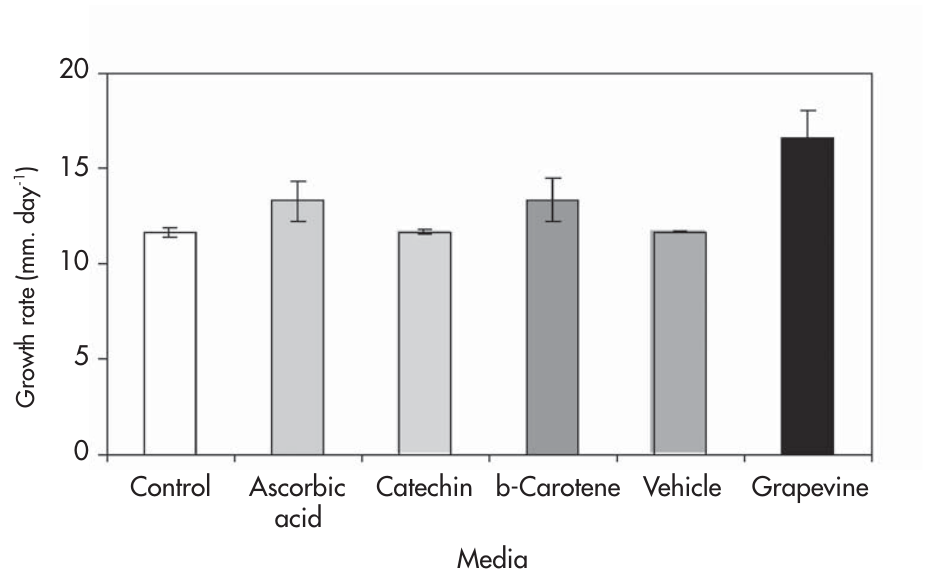
Fig. 5. Botryosphaeria parva growth in the presence of antioxidants. The fungus was grown in Czapek Dox modi fi ed solid medium with 2.5 mg ml-1 of antioxidant supplement: ascorbic acid, catechin and beta-carotene. As control, sim- ple Czapek Dox medium, Czapek Dox medium supplemented with the vehicle used to solubilize beta-carotene, and grapevine medium were used. The cultures were incubated for 3 days, in 7 cm diameter Petri